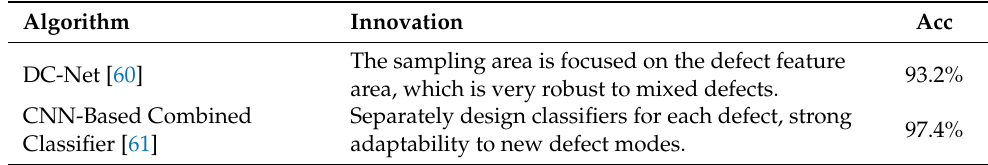
Table 3. Classification network model